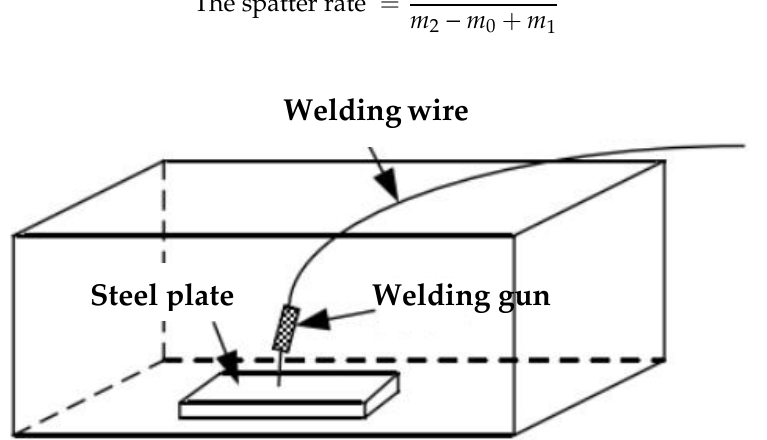
Figure 2. Schematic diagram of the welding spatter test equipment. Table 7. Chemical composition of weld metal (mass, wt